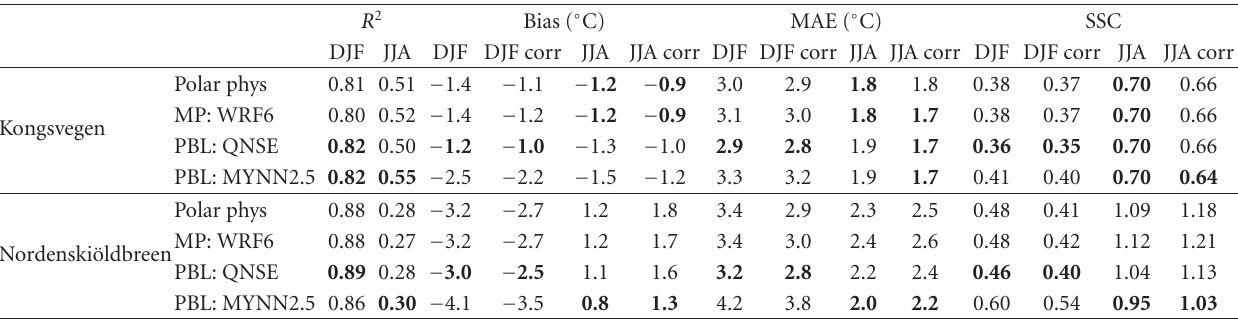
Table 9: Temperature in 2.7km resolution. Vestfonna data are not used here because of the lack of data during the chosen period. Bold numbers indicate the best result for each AWS. Abbreviation corr denotes height corrected temperatures.